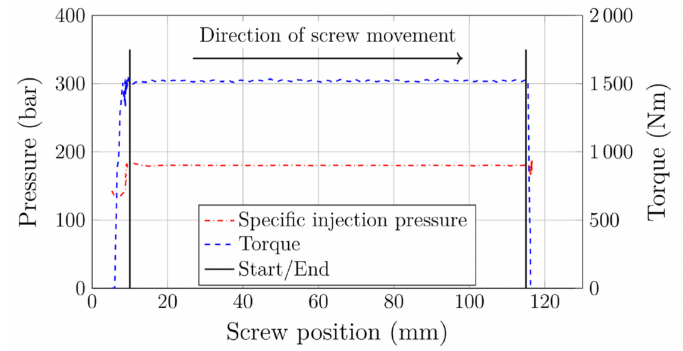
Figure 7. Specific injection pressure and torque within a dosing